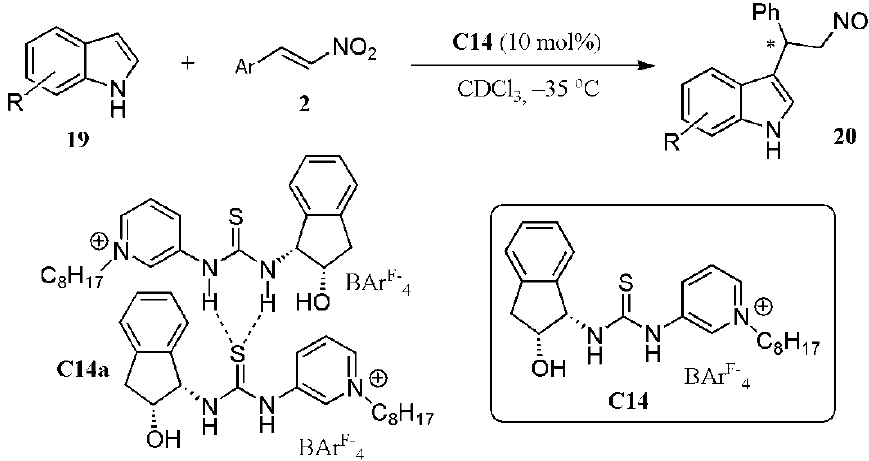
Figure 17. Enantioselective Friedel − Crafts alkylation between nitroalkenes and indoles catalyzed by charge activated thiourea organocatalyst C14; BArF 4 − = tetrakis(3,5-bis(trifluoromethyl)phenyl)borate anion [42].